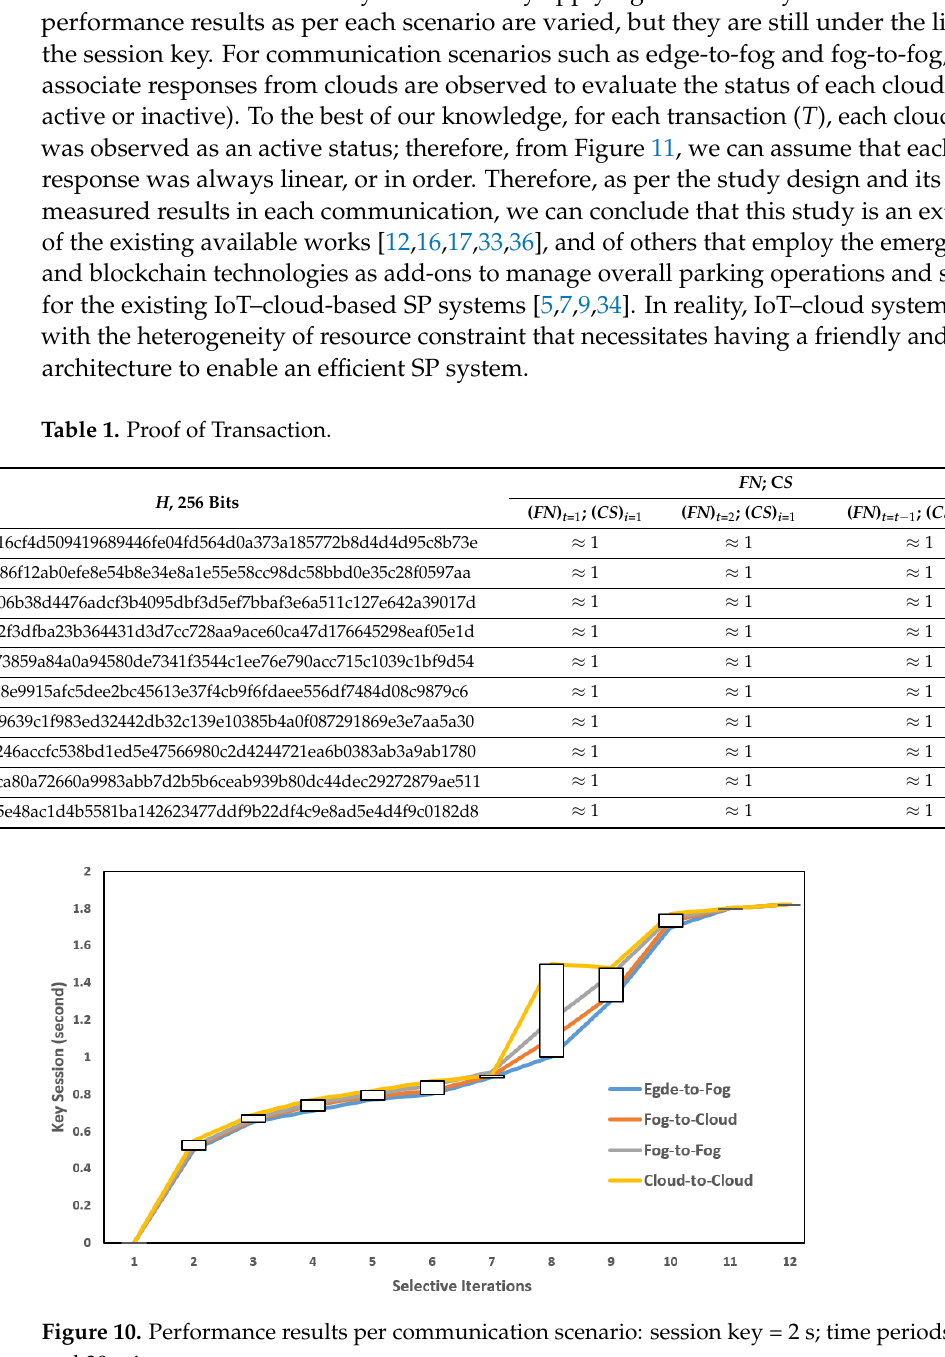
Figure 11. Performance Evaluation. 6. Challenges and Future Works